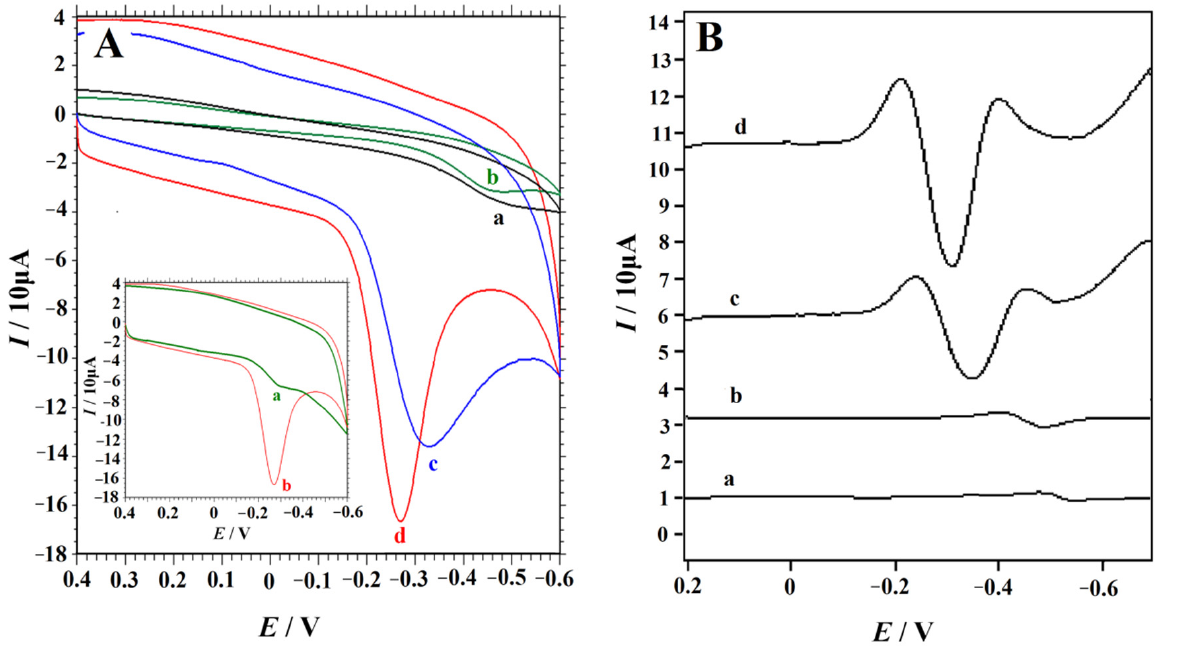
Figure 4. Cyclic voltammograms ( A ) and second-derivative linear sweep voltammograms ( B ) of 0.1 mM 4-NP in 0.2 M H 2 SO 4 solution obtained at bare GCE (curve a), PEI/GCE (curve b), NC/GCE (curve c) and NC–PEI/GCE (curve d) after accumulating at 0.2 V for 90 s, scan rate: 0.1 V s − 1 . Inset of a: CV curves of 0.1 mM 4-NP in 0.2 M H 2 SO 4 solution without accumulation (a) and after accumulation for 90 s (b).